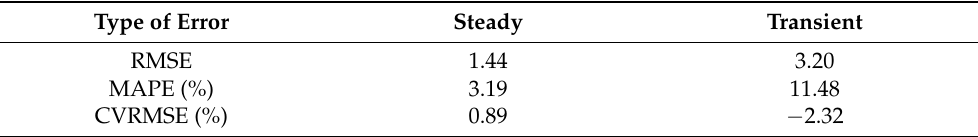
Figure 7. Comparison of the simulation and experimental results at room temperature: ( a ) steady state; ( b ) transient process. Table 4. Error evaluation indexes of the simulation